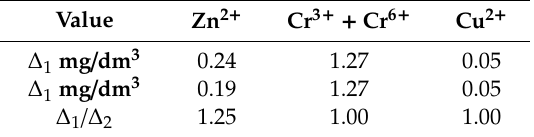
Table 6. Comparison of purification results when changing the pulse frequency.